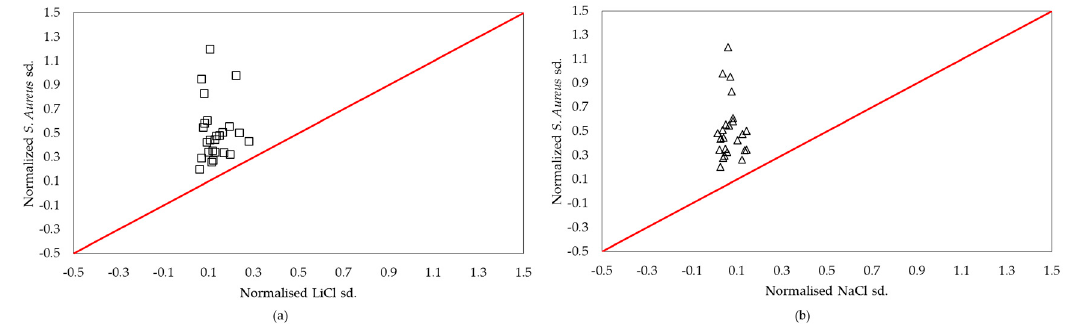
Figure 6. Plots of normalized standard deviation (sd.) for ( a ) S. aureus vs. LiCl ( b ) S. aureus vs. NaCl. Solid red line indicates 1-to-1 relationship.